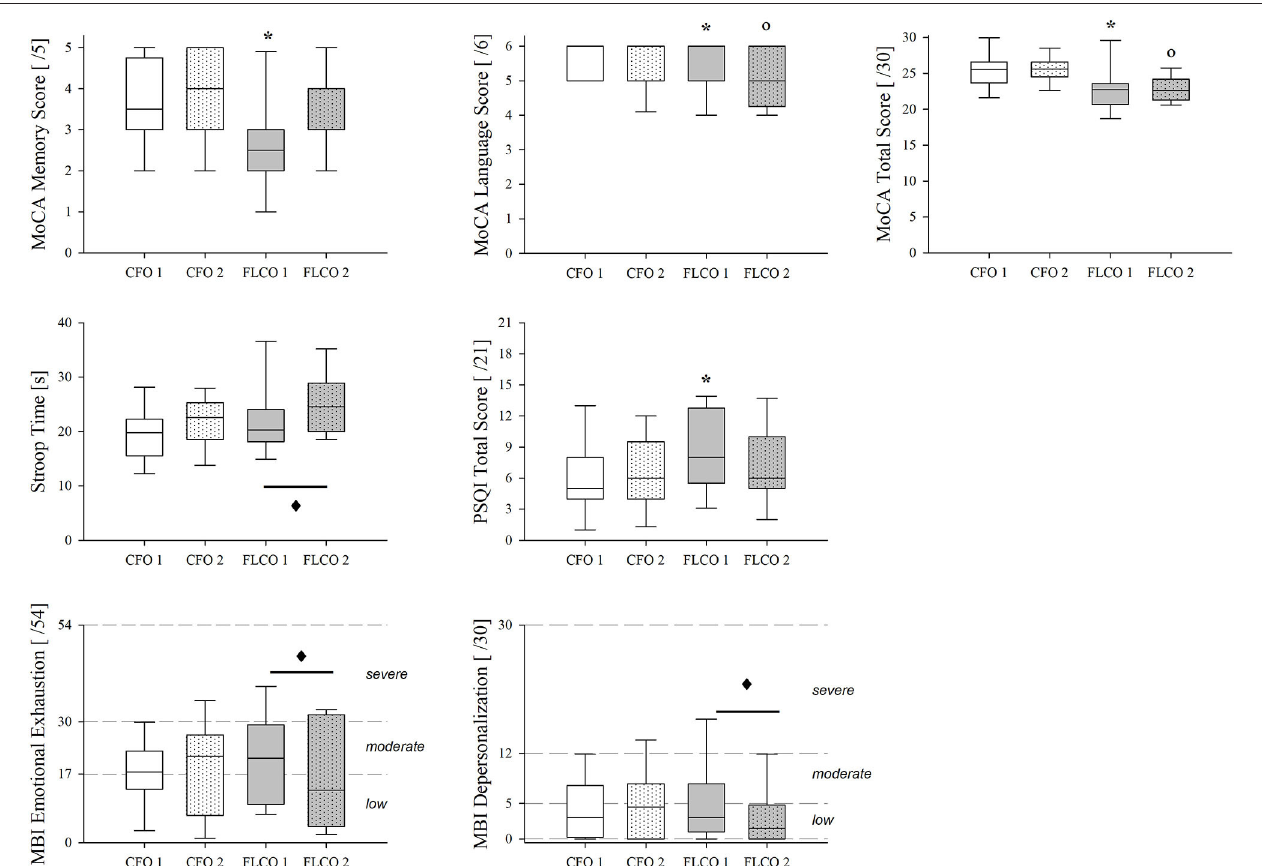
FIGURE 4 | A box-and-whisker plot representing the median (line within the box), the interquartile range (length of the box), the 90th and 10th percentiles (whiskers above and below the box) of cognitive tests, and surveys results: MoCA memory score (top left panel), MoCA language score (top central panel), MoCA total score (top right panel), Stroop Color and Word Test time duration (middle left panel), Pittsburgh Sleep Quality Index Total Score (middle central panel), MBI-GS Emotional Exhaustion (bottom left panel), and depersonalization (bottom central panel) in operators who worked in COVID-19-free wards and departments (CFO, white) and in frontline COVID-19 operators during the pandemic (FLCO, gray) during the first (1) and the second sessions (2). * p < 0.05 CFO1 vs. FLCO1; ◦ p < 0.05 CFO2 vs. FLCO2; (cid:7) : p < 0.05 FLCO1 vs.